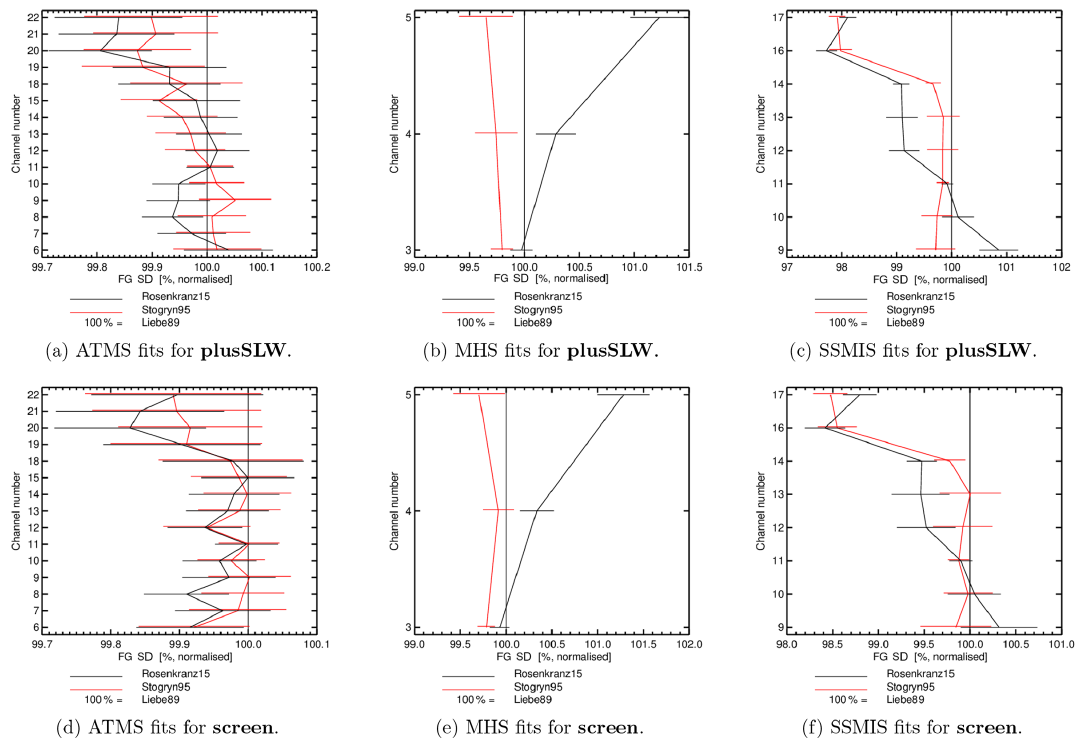
Figure 12. Standard deviation in FG departure in the Southern Hemisphere of ATMS, MHS and SSMIS for Rosenkranz15 and Stogryn95 normalised by Liebe89 for plusSLW and for screen. Different colours refer to different liquid water permittivity models, as shown in the figure. The horizontal bars indicate 95% confidence range. Results cover the time period from 1 June to 30 September